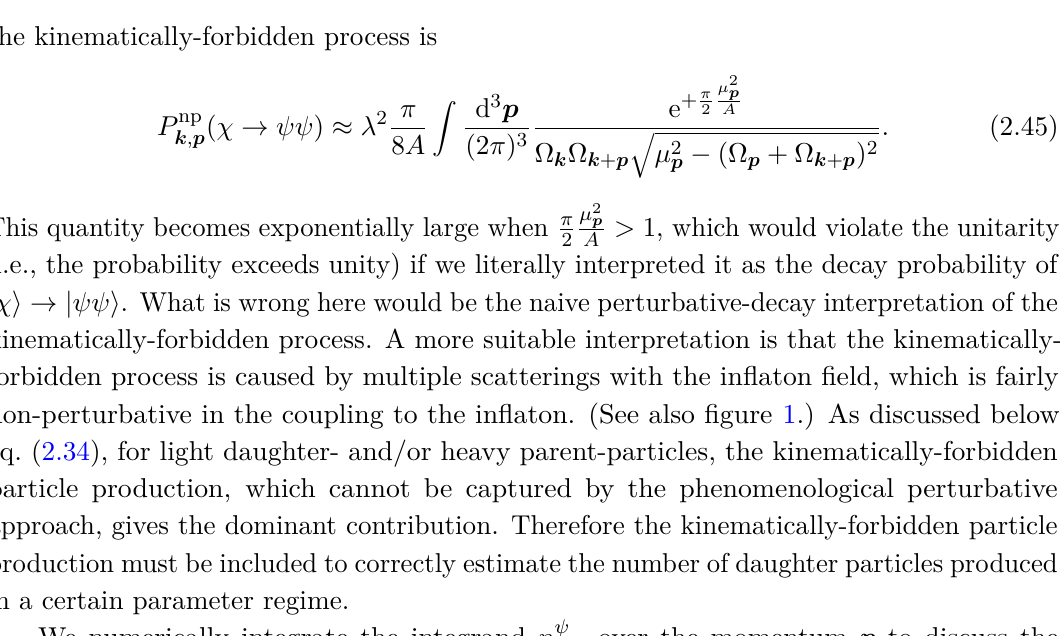
Figure 4 . The number of daughter particles produced n ψ as a function of the momentum k for k M min = m ψ (left) and M min = 3 m ψ (right) with various values of A . The thick and dashed lines χ χ show the non-perturbative result in the slow-field limit (2.38) and the phenomenological perturbative result (2.41), respectively. The other parameters are fixed as a ( t prod ) = 1 and λ = 1